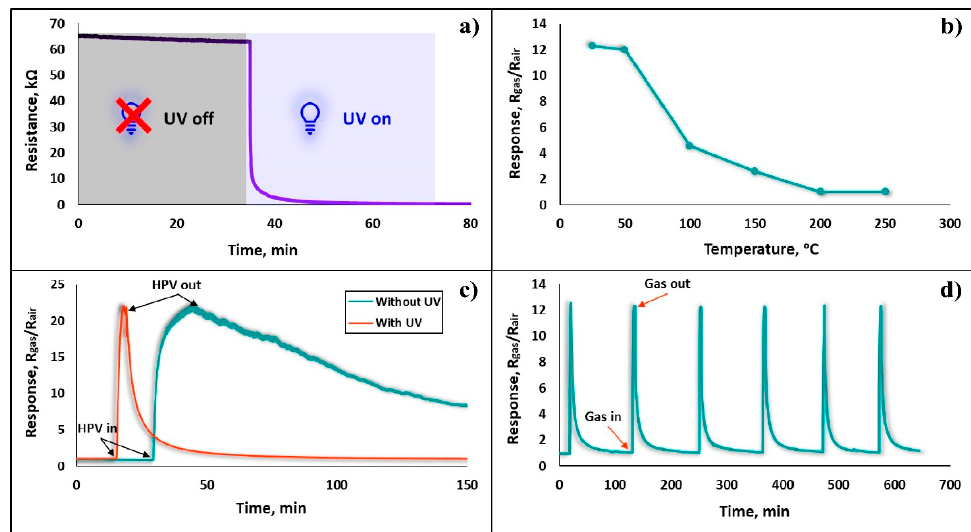
Figure 10. ( a ) UV response of the Fe 2 O 3 :ZnO sensor at RT, ( b ) sensor response vs operating temperature under UV irradiation, ( c ) dynamic response curves of the sensor to 3 and 225 ppm concentrations, with and without UV irradiation, respectively, ( d ) repeatability test of the sensor exposed to 1.5 ppm HPV under UV irradiation.